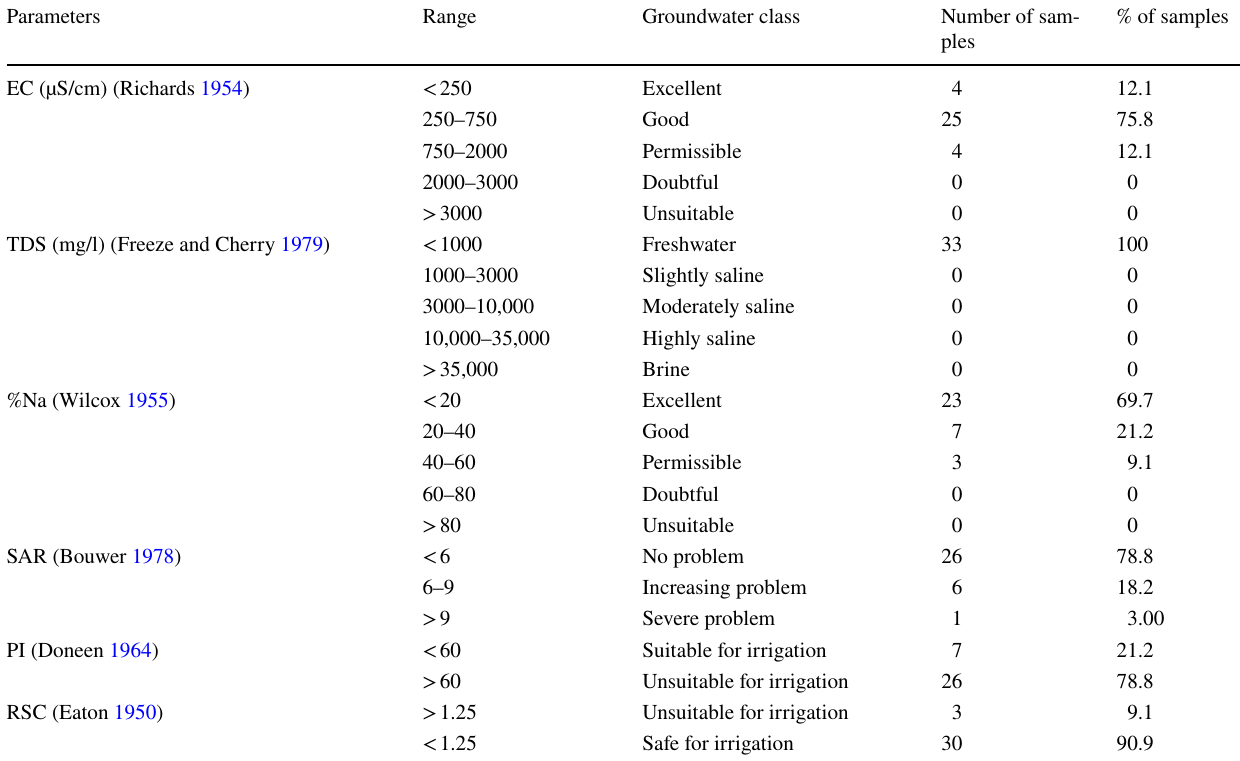
Table 7 Classification of groundwater for irrigational use based on irrigational indices Parameters